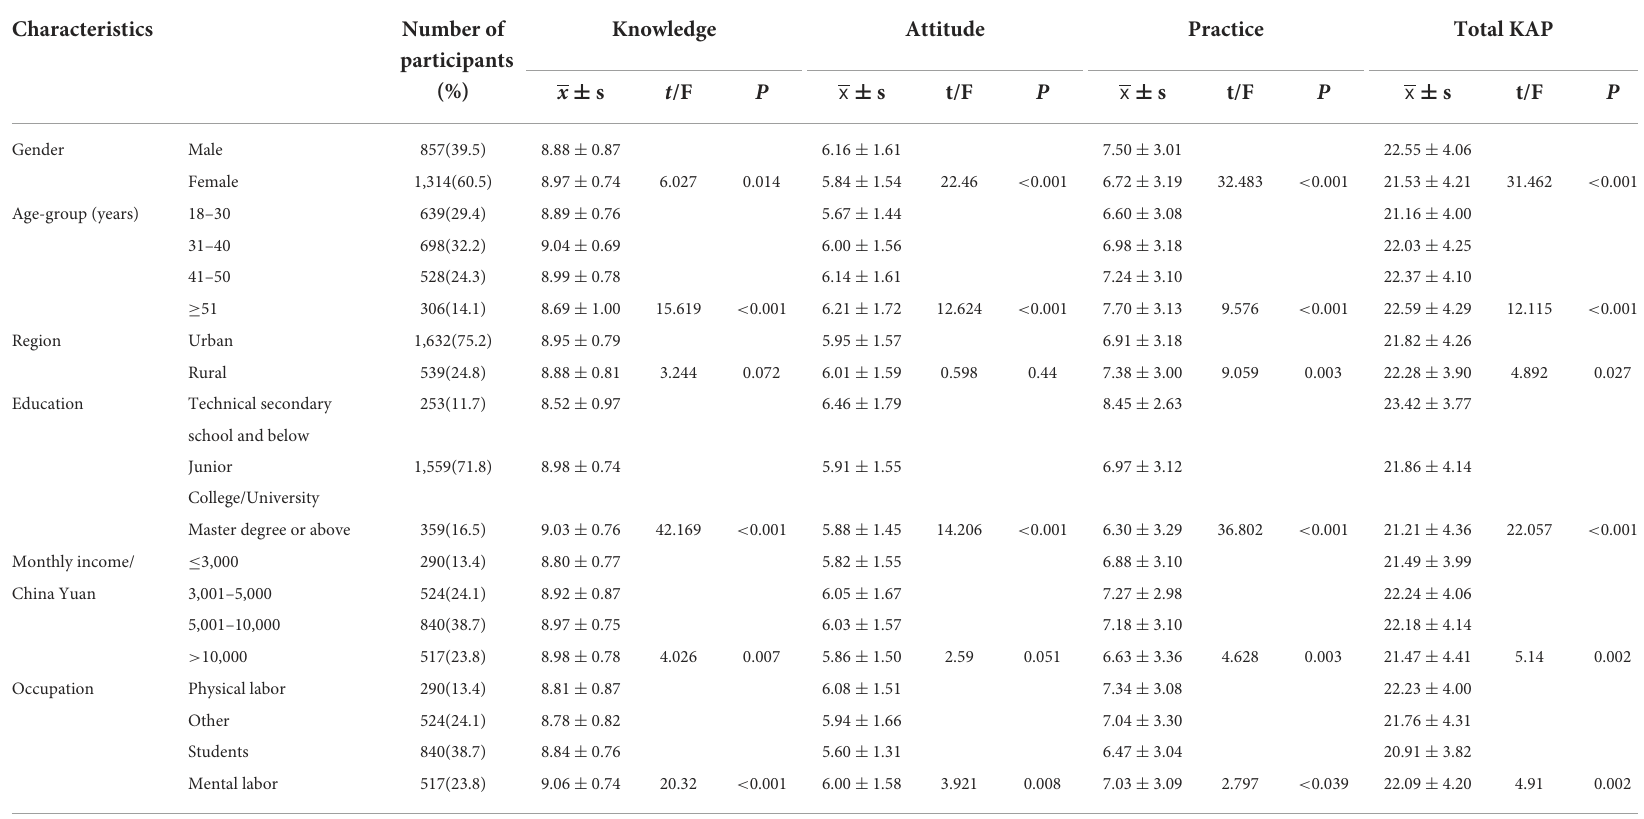
TABLE 5 Comparison of COVID-19 related KAP scores between different characteristics.